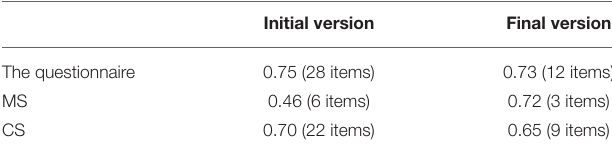
TABLE 4 | CERSQ’s reliability in the initial and final